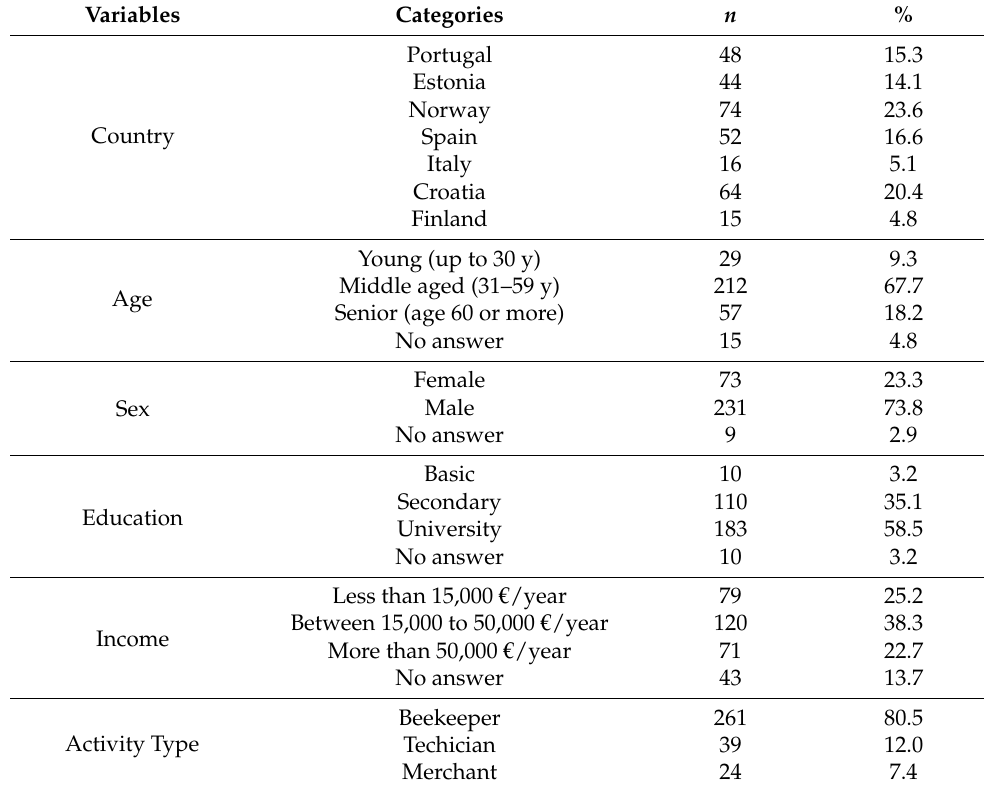
Table 2. Sociodemographic characterization of the sample (N =